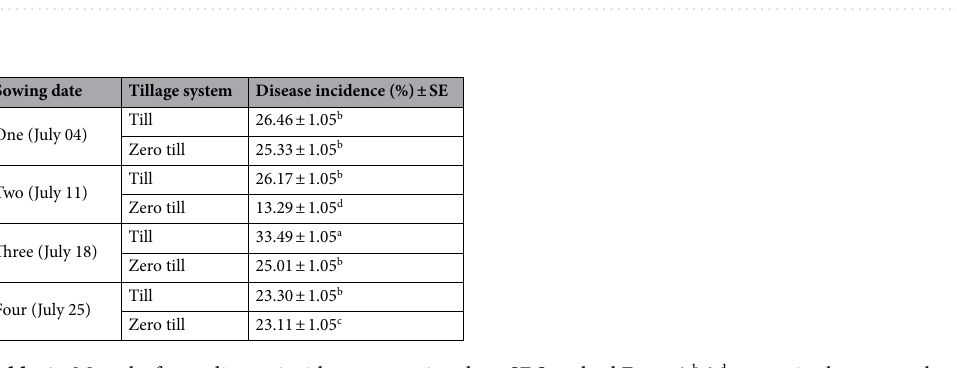
Table 6. Mean leaf spot disease incidence at sowing date. SE Standard Error. a, b, c, d means in the same column with the same superscript are not significantly different at p < 0.05 (DMRT).